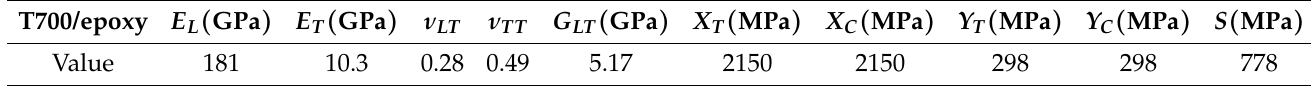
Figure 20. Fiber/epoxy composite layers. Table 4. Mechanical properties parameters of T700/epoxy composite layer.